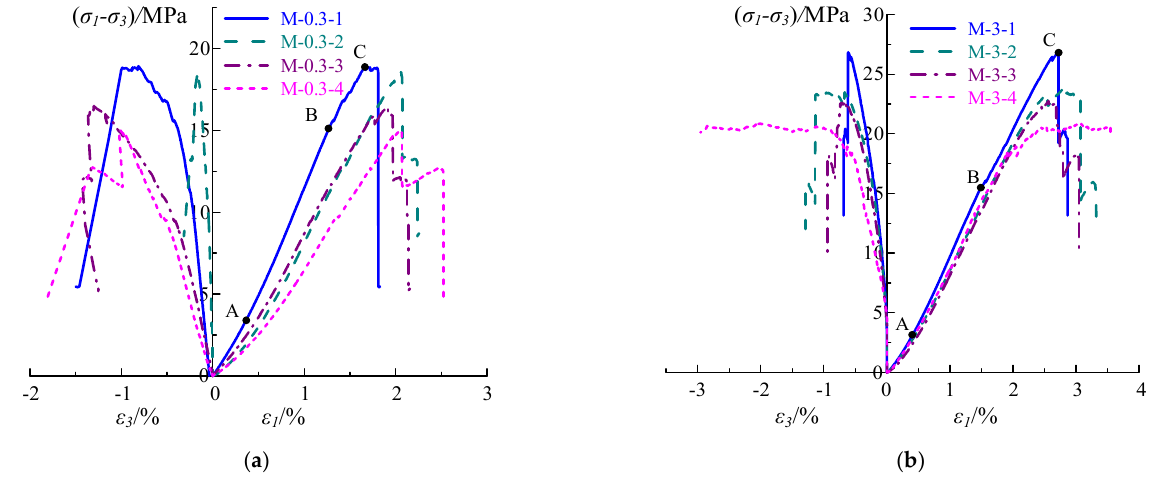
Figure 4. Stress − strain curves of fractured coal specimens. ( a ) Confining pressure 0.3 MPa; ( b ) con- fining pressure 3 MPa.